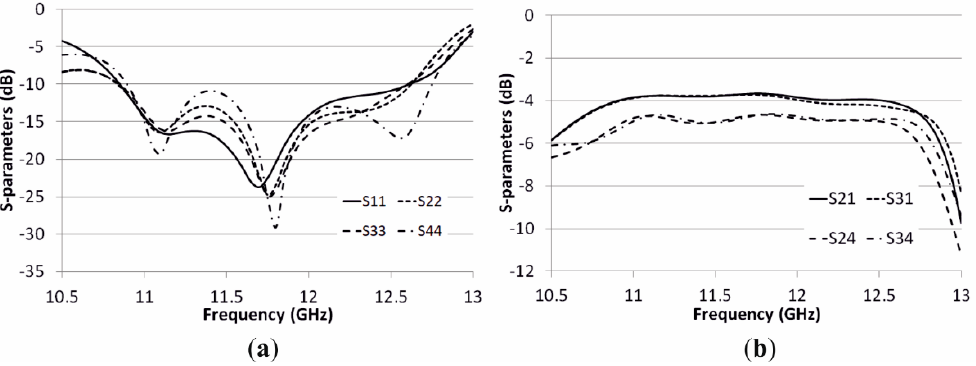
Figure 15. Experimental response of the single-layer Magic Tee prototype shown in Figure 14. ( a ) Reflection coefficients; ( b ) Transmission coefficients.